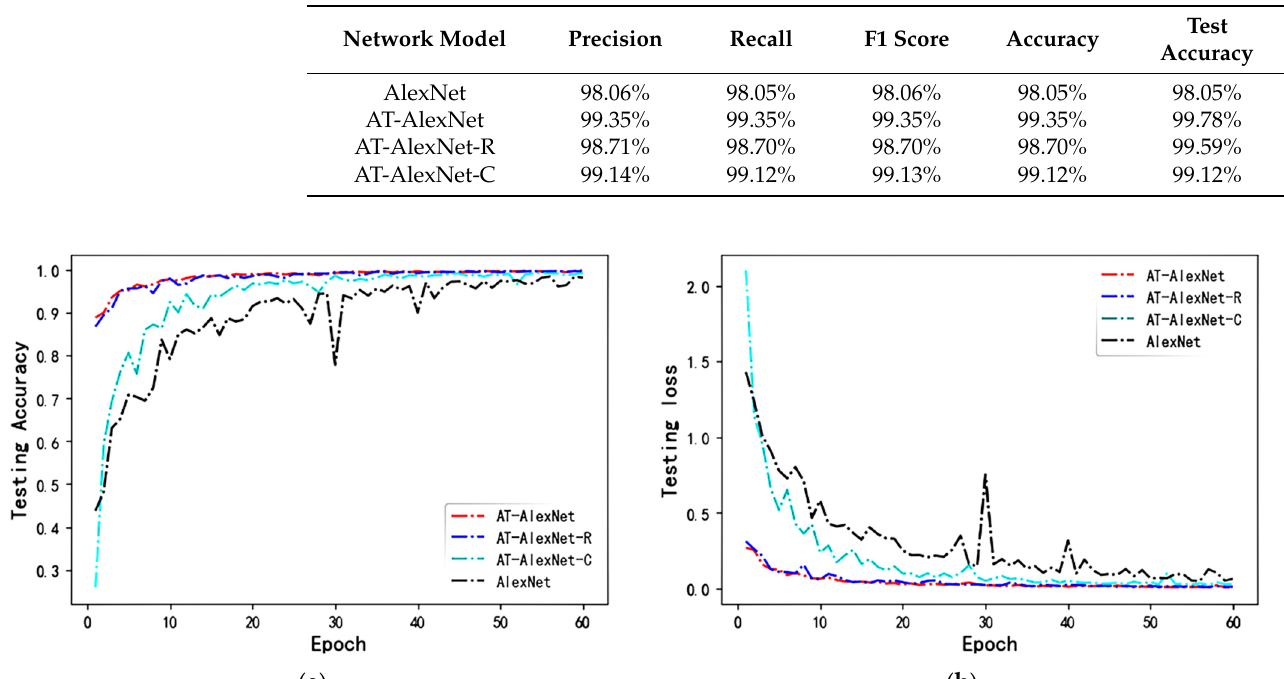
Table 5. AT-AlexNet network ablation test.